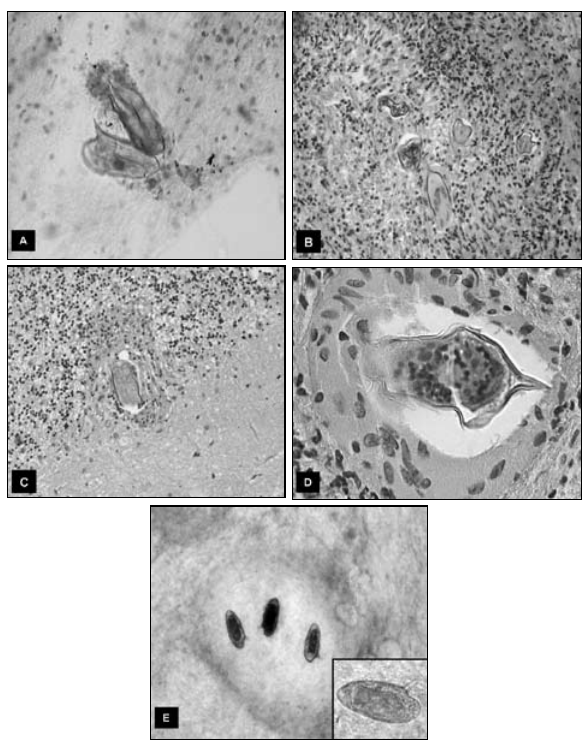
Figura 2 – A: Esmagamento linear (HE 200X) – ovos evidentes e preservados em meio a tecido cerebelar e células inflamatórias; B: cerebelo (HE) 200X – cortical cerebelar contendo numerosos granulomas constituídos por histiócitos e gigantócitos envolvendo ovos de Schistosoma mansoni ; C: cerebelo H.E. (HE 200X) – ovos presentes entre as camadas molecular e granular interna; D: cerebelo (HE 400X) – granuloma com gigantócito multinucleado contendo ovo espiculado; E: reto – biópsia retal por vitrotransparência mostra numerosos ovos no sombreado de um granuloma. Encarte: detalhe do ovo com espícula